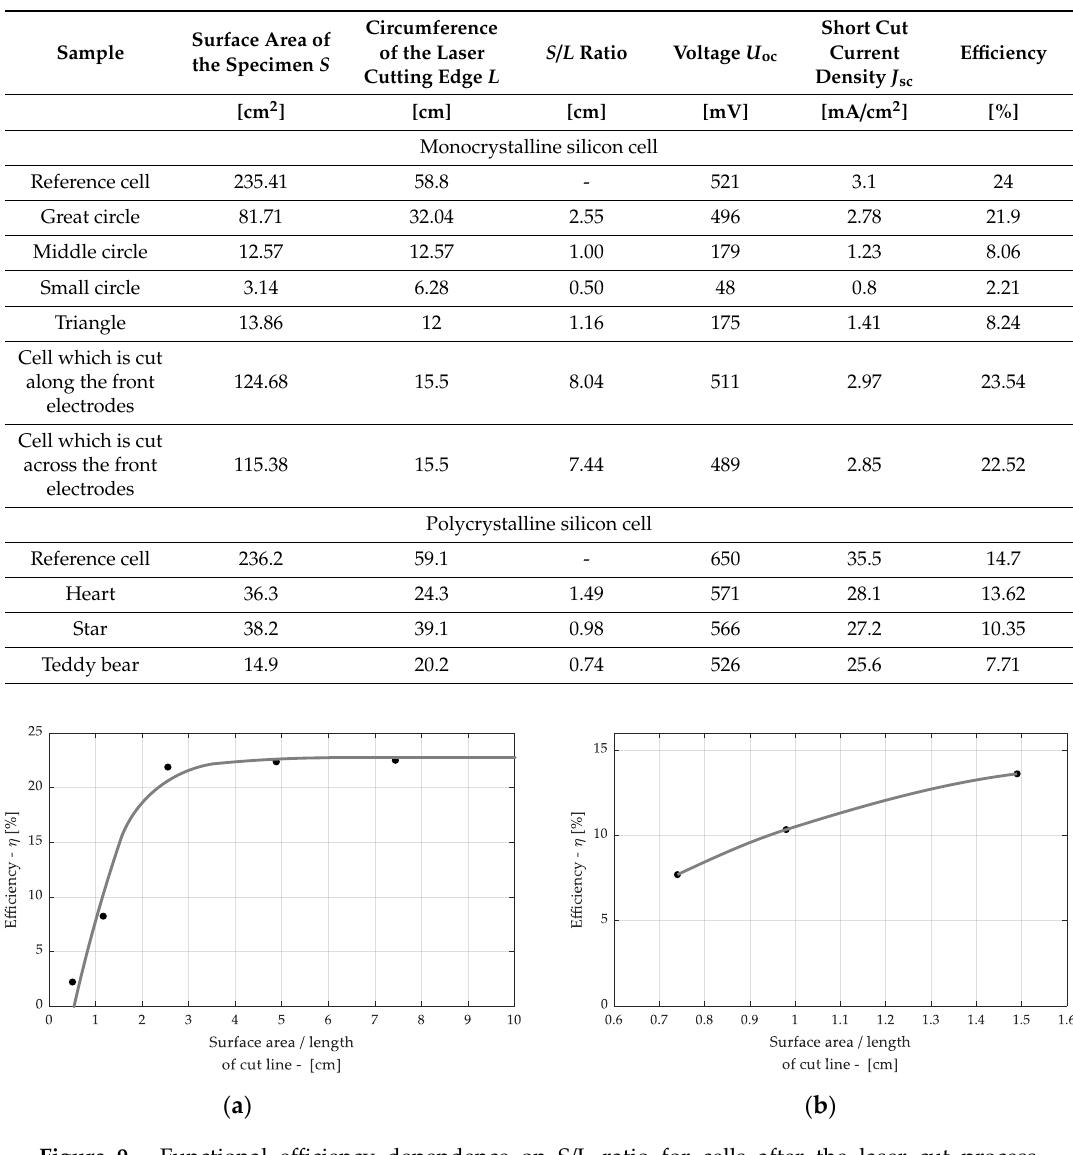
Table 4. Parameters of examined samples.